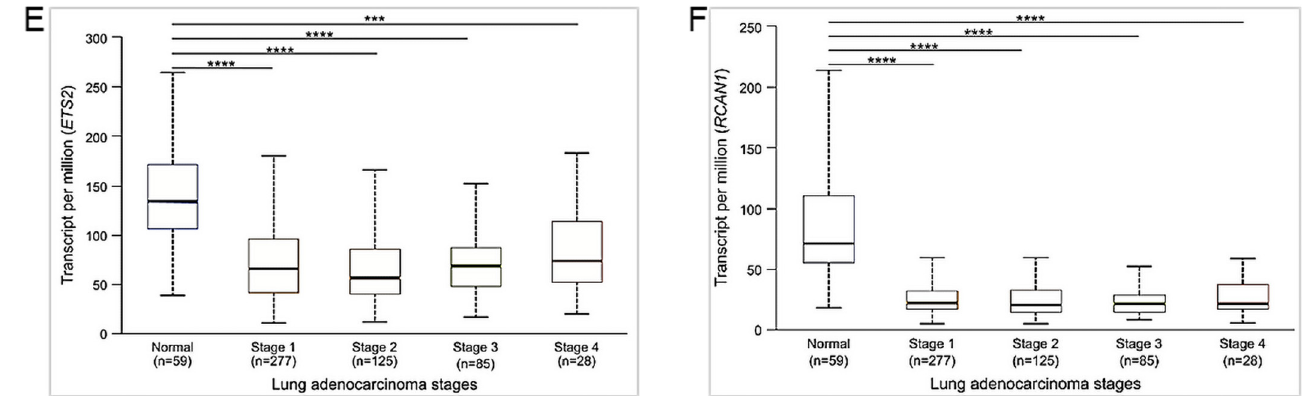
Figure 4. Expression of ETS2 and RCAN1 in breast and lung cancers based on stages and subtypes. Boxplots represent mRNA expression of ( A ) ETS2 and ( B ) RCAN1 in breast cancer stages; ( C ) ETS2 and ( D ) RCAN1 in breast cancer subtypes; and ( E ) ETS2 and ( F ) RCAN1 in lung cancer stages. * p ≤ 0.05, *** p ≤ 0.001, **** p ≤ 0.0001. Non-significant differences are not shown.